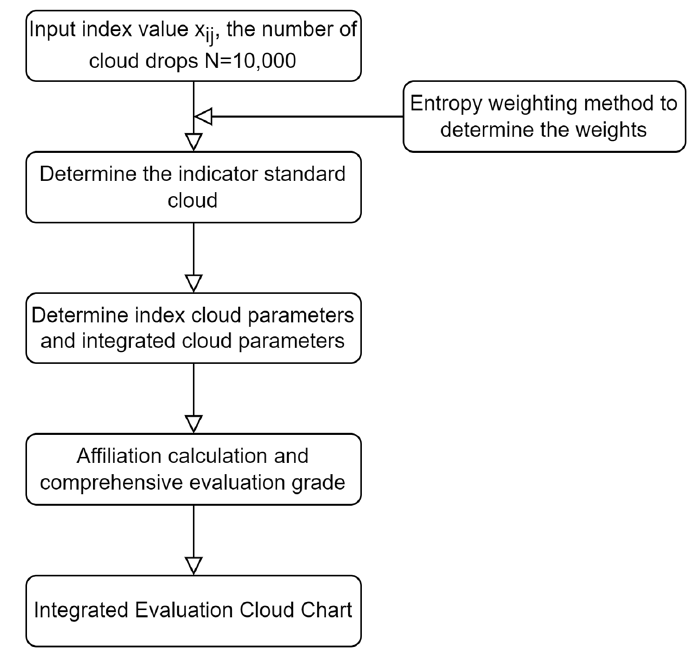
Figure 1. Evaluation process of the cloud model for the ERP.